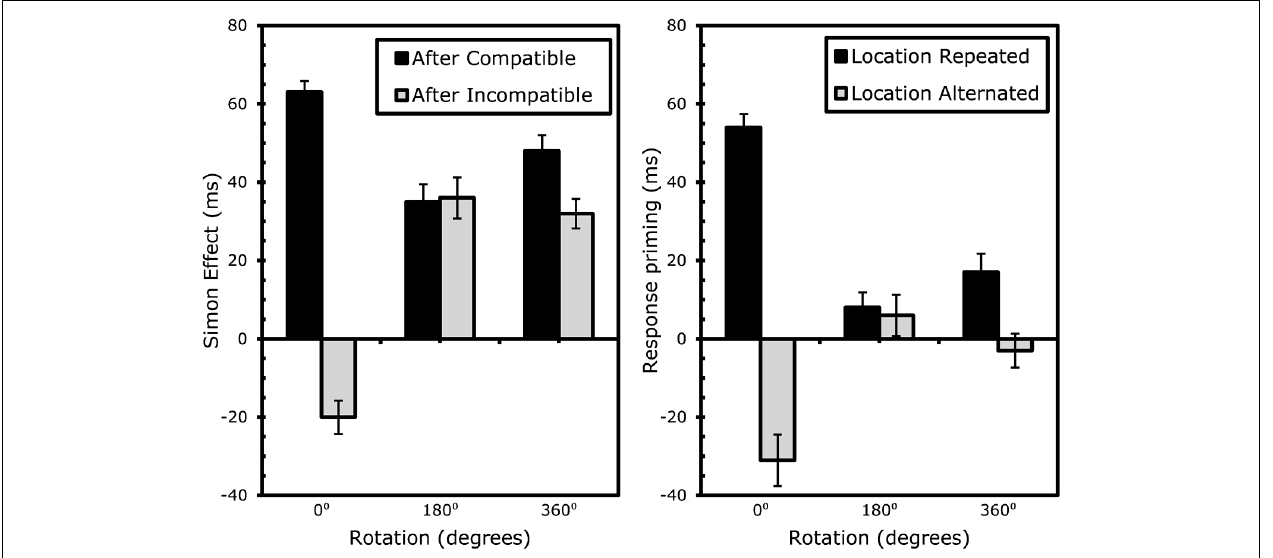
FIGURE 5 | Results Experiment 3: effects of rotation on sequential Simon effects (left) and event-coding (right). Error bars represent standard error of the Simon (left) or response-priming (right) effect within the specific condition.